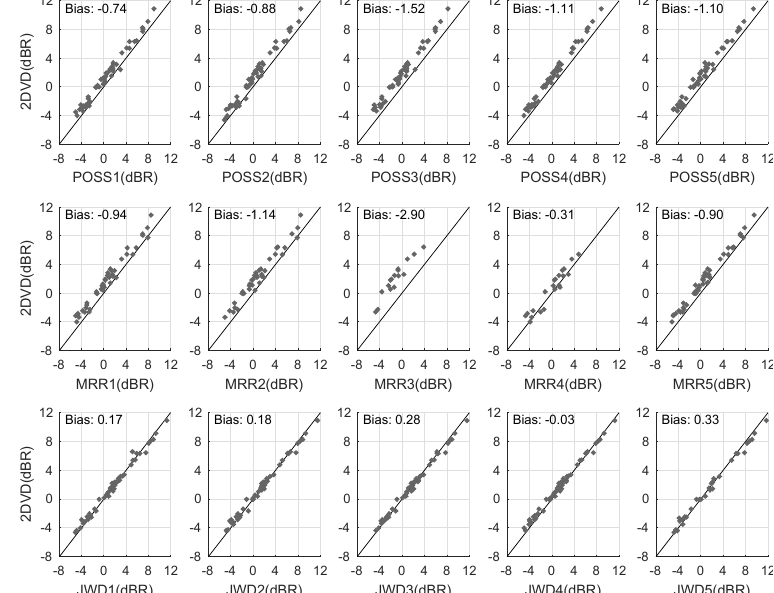
Figure 4. The hourly mean rainfall rate (dBR) from each disdrometer. The mean bias values (dB) of POSS, MRR and JWD compared to 2DVD are shown for each disdrometer on the top of each panel. The results show that the biases were slightly di ff erent for di ff erent parameters (R and Z) and averaging windows (hourly and one-minute). However, their trends were consistent. For example, M3 had the largest biases of about − 2.9– − 3.5 dB. Thus, the mean biases for individual disdrometers (except 2DVD) were determined by averaging the one-minute and hourly R and Z biases (summarized evident for JWD as shown in the comparison with the